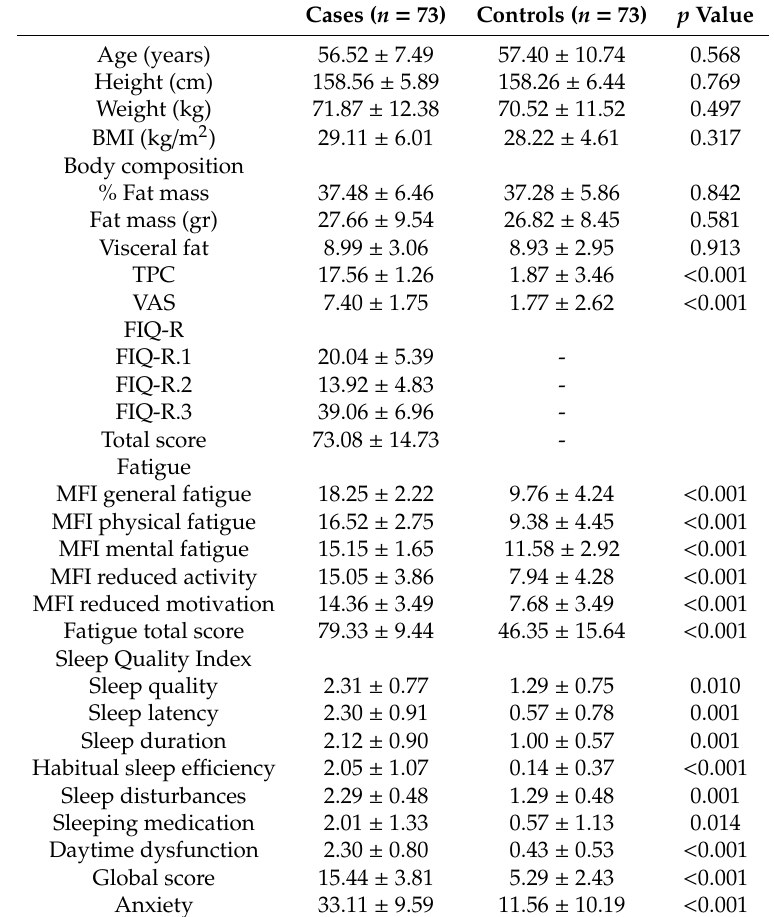
BMI: body mass index, TPC: tender points count, VAS: visual analog scale, FIQ-R: revised Fibromyalgia Impact Questionnaire,FIQ-R.1: levelofactivity,FIQ-R.2: globalimpact,FIQ-R.3: symptomsintensity,MFI:multidimensional fatigue inventory. Numerical variables are shown as mean ± SD (Standard